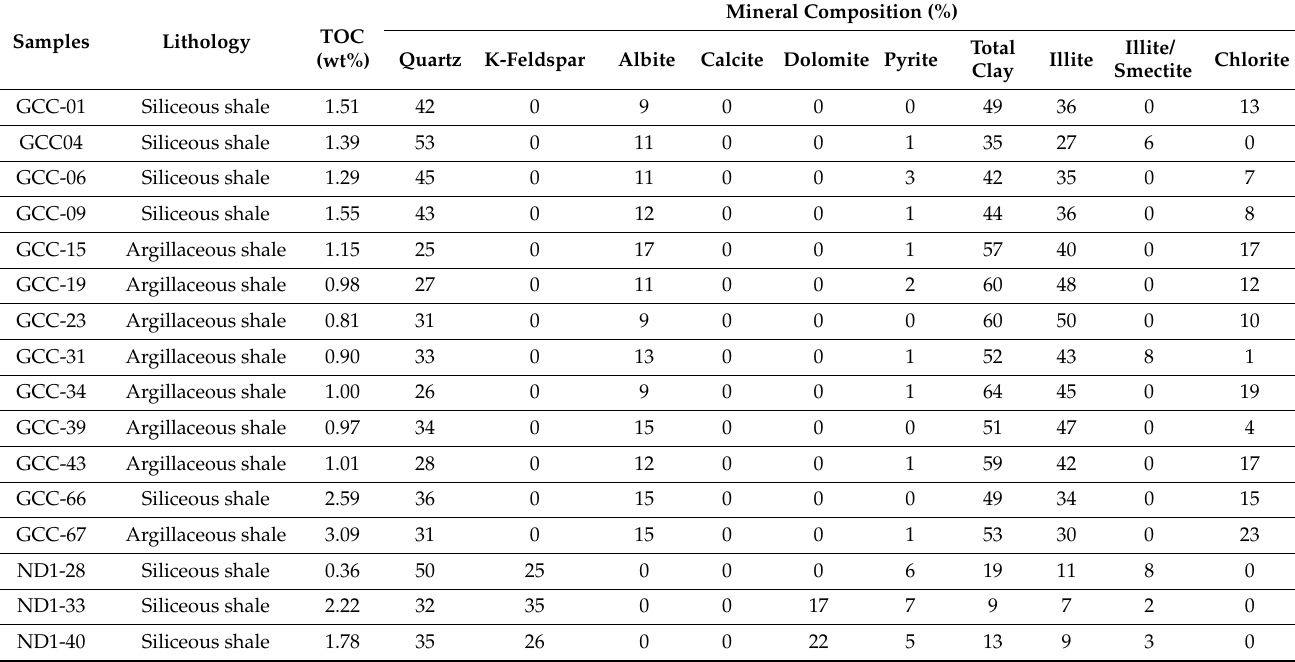
Table 1. TOC and Mineral composition of Niutitang Formation in GCC section, ND1 well and YWT